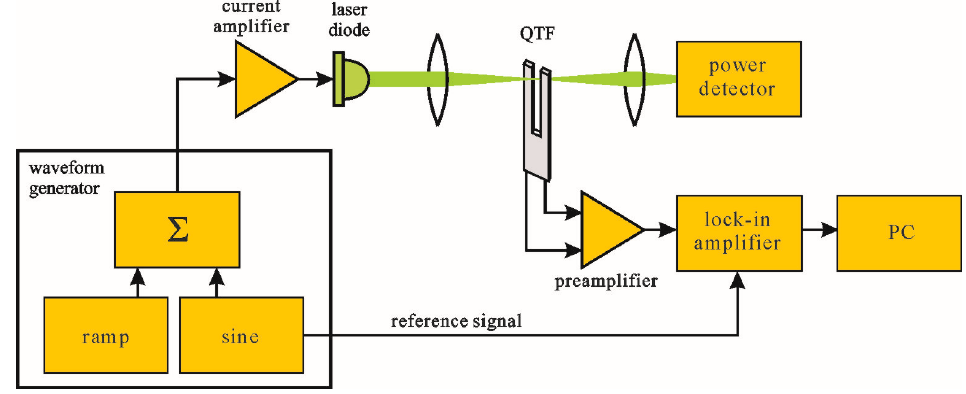
Figure 1. An example of a QEPAS setup block diagram.